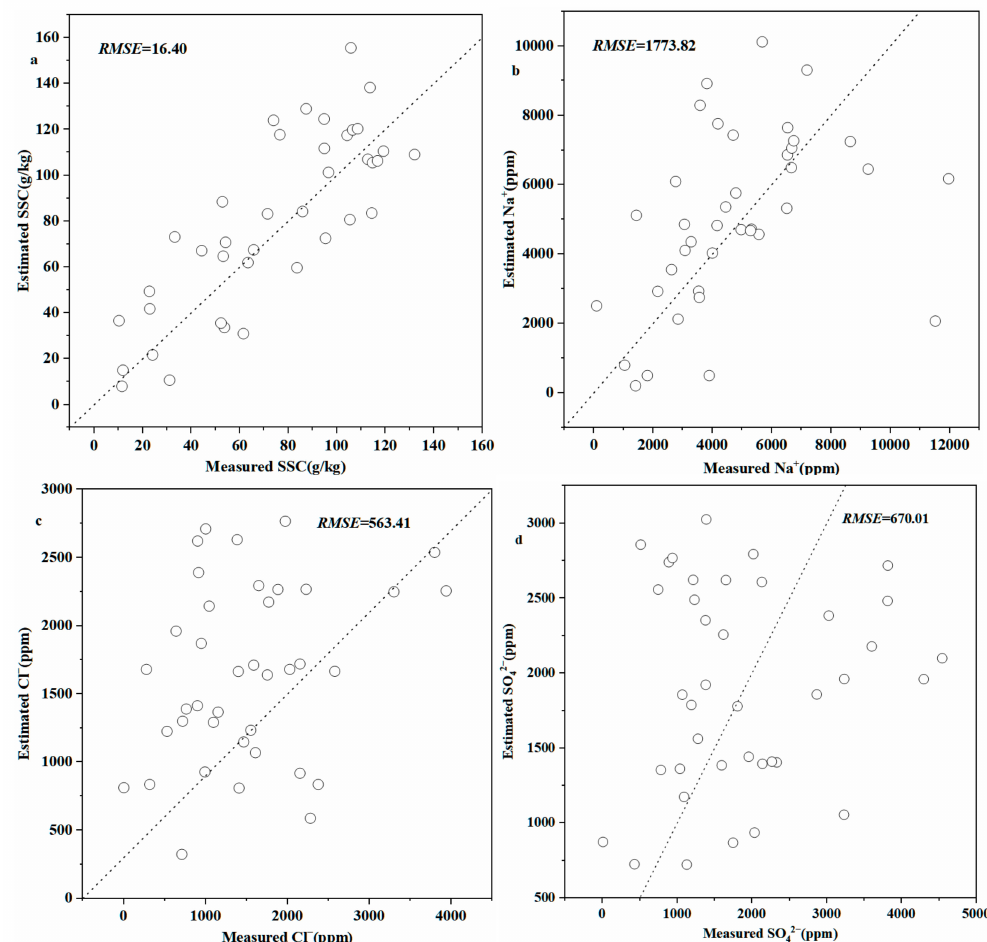
Figure 8. Relationship between the results for each soil component estimated using optimal data transformation and the best modelling methods and results for the actual measured soil components. ( a ) The relationship between measured SSC and estimated SSC; ( b ) the relationship between measured Na + content and estimated Na + content; ( c ) the relationship between measured Cl − content and estimated Cl − content; ( d ) the relationship between measured SO 42 − content and estimated SO 42 −